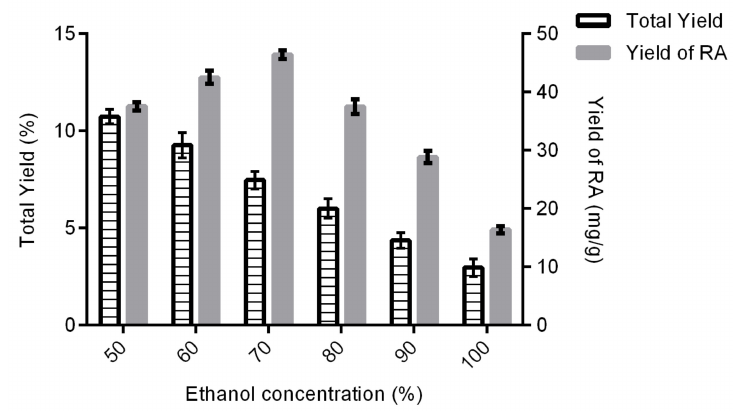
Figure 2. E ff ect of ethanol concentration on total yield and yield of rosmarinic acid. Experiment was conducted in triplicates ( n =